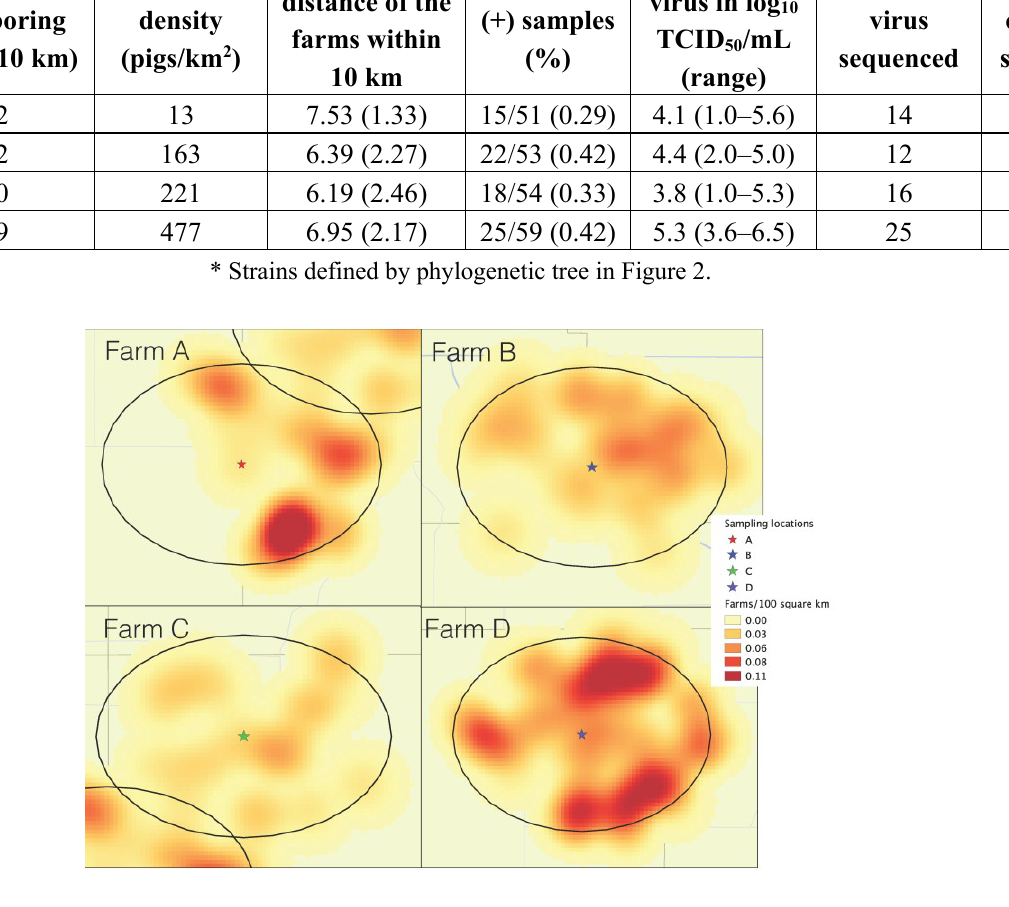
Figure 1. Farm density kernel within 10 km of each of the air sample locations: Farm A (South Dakota), farm B (Northeast Iowa), farm C (Southwest Minnesota), farm D (Northwest